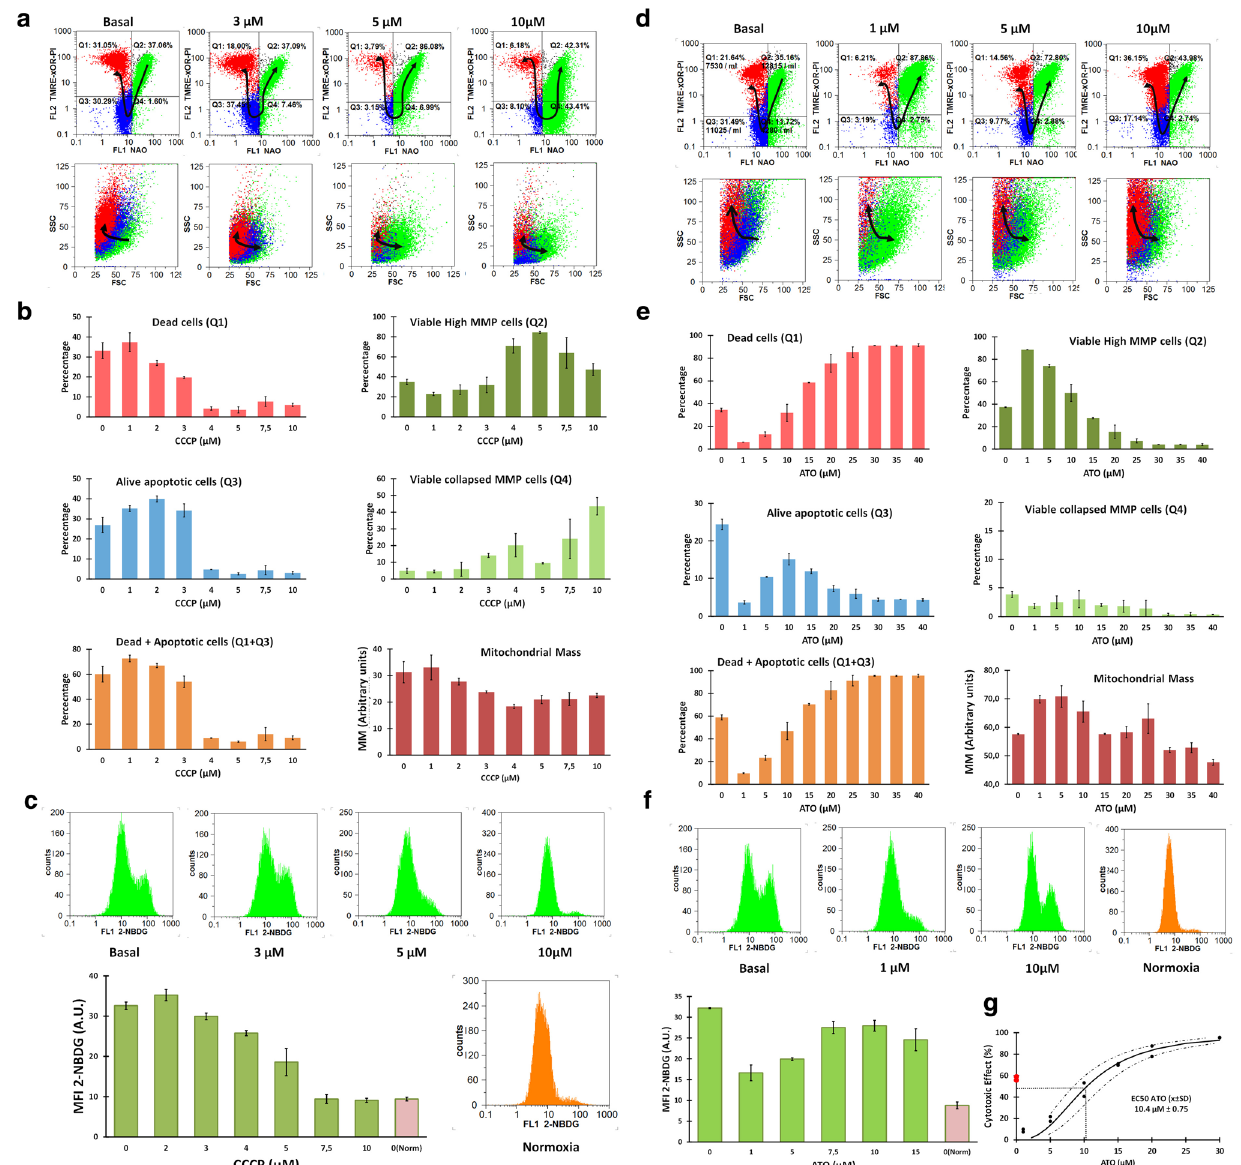
Fig. 3 Cytotoxic effect of CCCP and ATO at 72 h under hypoxia in BC-K562 cells. a Representative dot plots of CCCP-treated cells under hypoxia. Dead and apoptotic cells (red and blue dots respectively) were about 60% in untreated cells but decreased with increasing CCCP dose, while live cells with rdCL (green dots) augmented, even showing collapsed MMP (Q4). b Bar graphs showing CCCP pro-survival effect with percentage of dead and apoptotic cells (Q1 and Q3 respectively), live cells with rdCL either with high MMP (Q2) or collapsed MMP (Q4), and MM changes with increasing CCCP dose. c Five representative histograms of cells labelled with 2-NBDG, and a bar graph showing decreased glucose uptake with increasing CCCP dose, approaching the same values observed in normoxia. MFI: mean fluorescence inten- sity; A.U. arbitrary units. d Representative dot plots of ATO-treated cells under hypoxia. Dead and apoptotic cells (red and blue dots respec- tively) decrease only at 1-5 μM ATO compared to untreated cells, and increased at higher ATO doses. e Bar graphs showing percentage of dead and apoptotic cells, live cells with rdCL and high MMP and MM changes with increasing ATO dose. Q1 + Q3 figures shows a biphasic shape with decline and rapid increases in cell death with ATO. f Four representative histograms of cells labelled with 2-NBDG, and a bar graph showing mostly high glucose uptake with increasing doses of ATO, close to that of untreated cells under hypoxia. MFI: mean fluores- cence intensity; A.U. arbitrary units. g Regression dose–response curve using the median effect equation, with EC50 of ATO obtained at 72 h treatment. Red dots (untreated cells) show that ATO rescues cells from hypoxia below 5 μM and further kills cells at higher